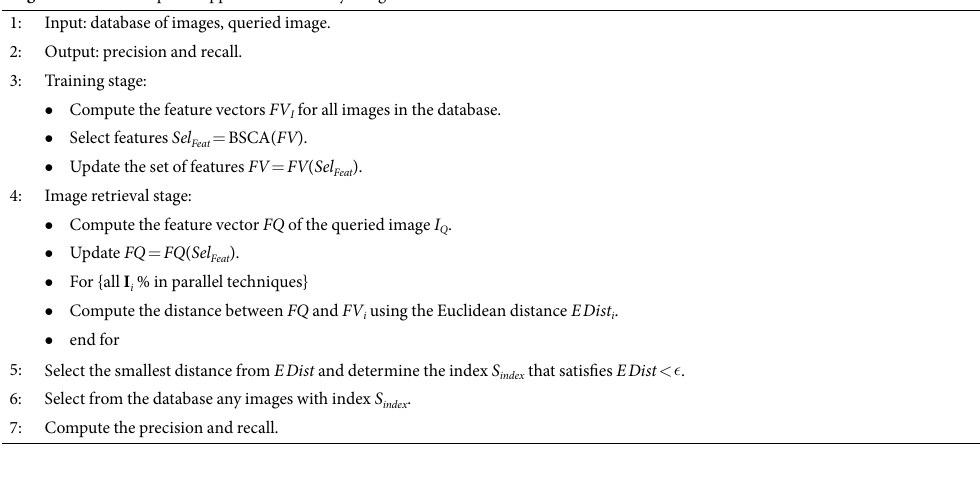
Algorithm 2 Binary Sine Cosine Algorithm (BSCA)